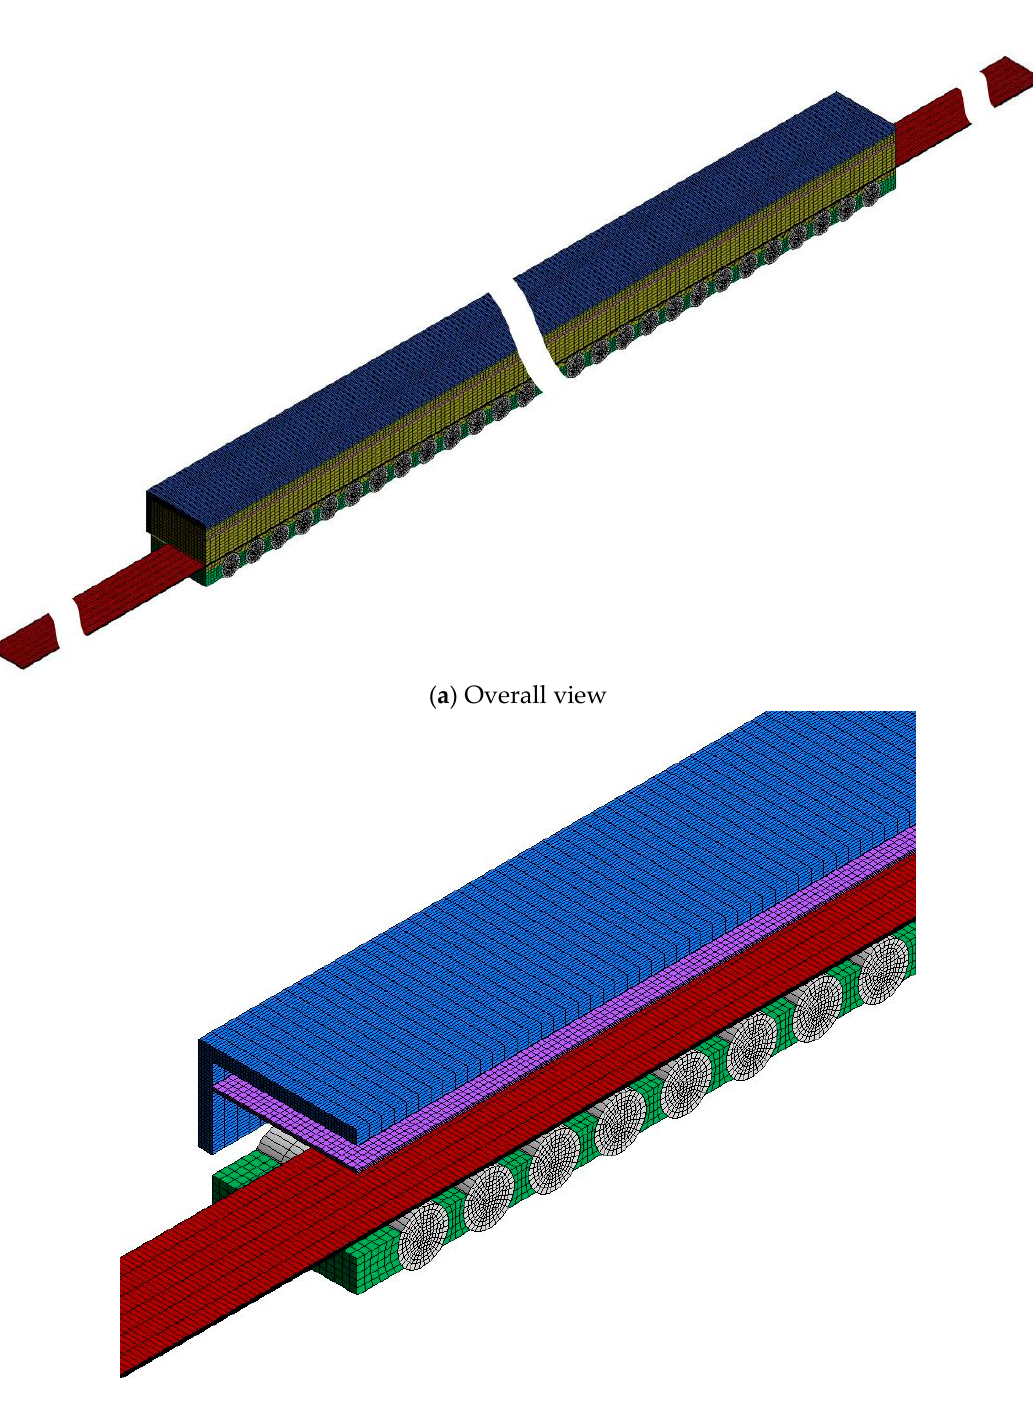
Figure 6. Computational grid systems of the acting-type heat retention panel.